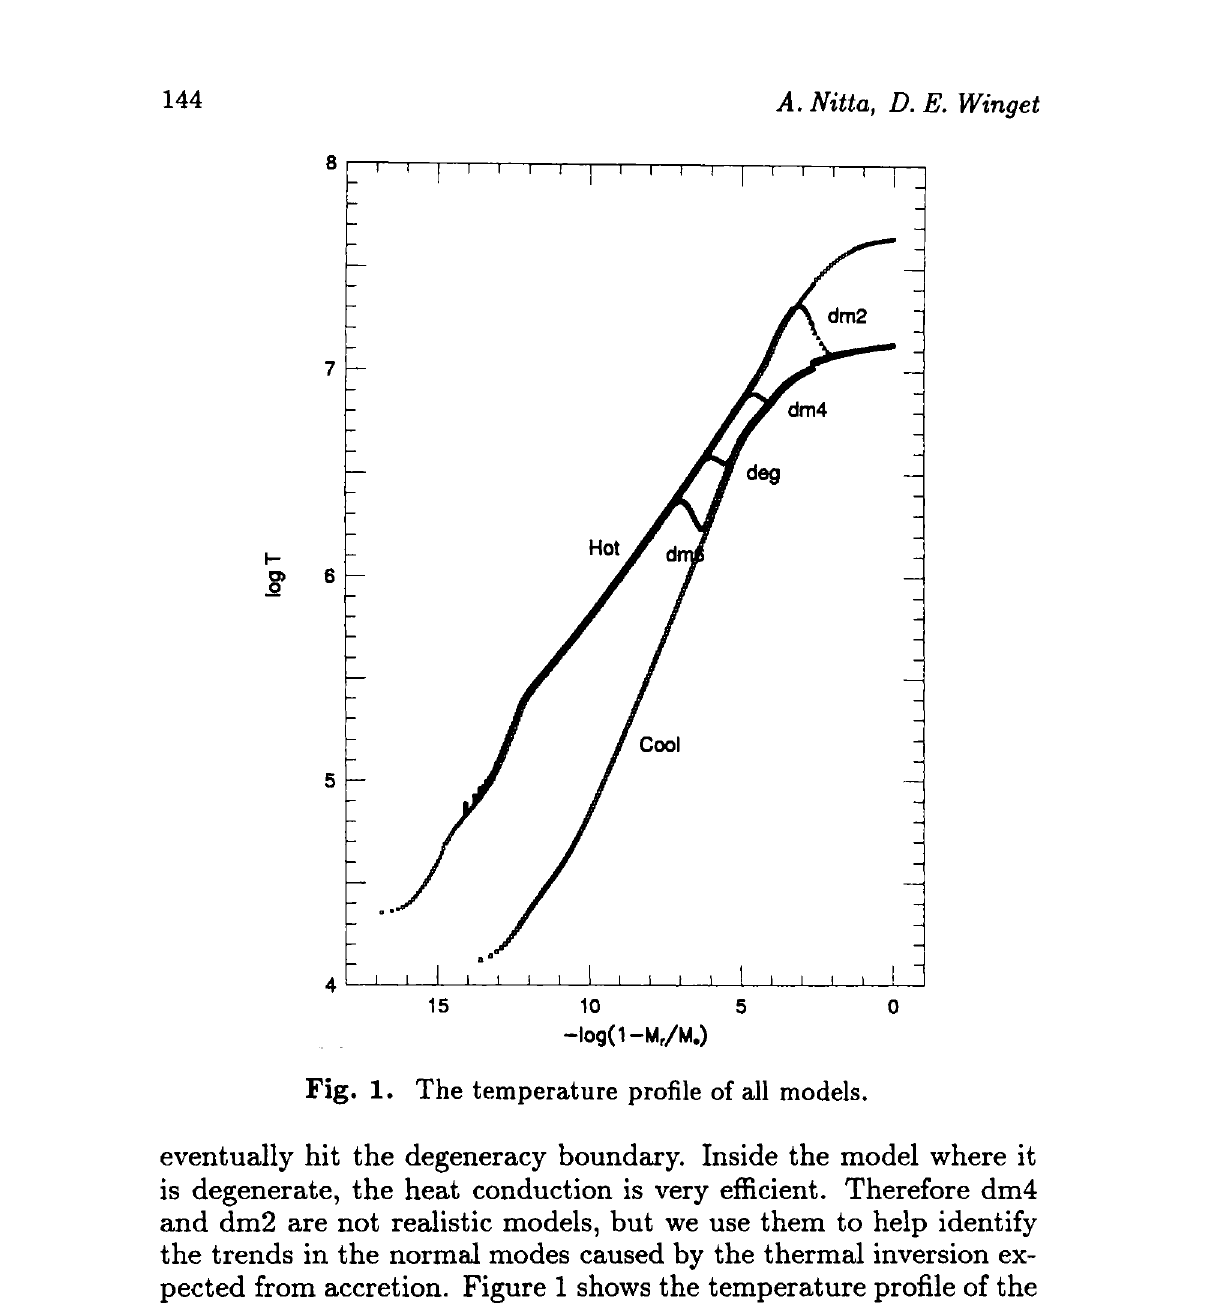
Fig. 1. The temperature profile of all